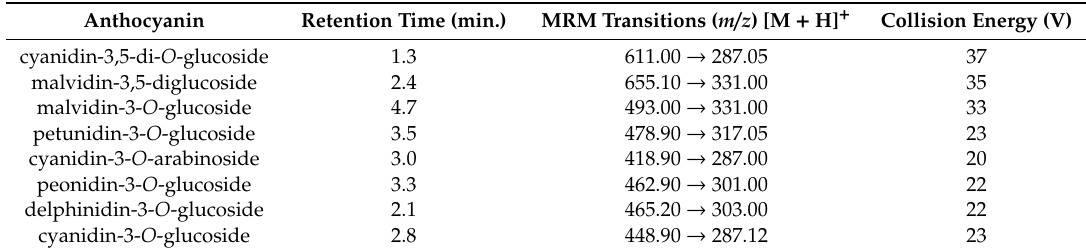
Table 1. Optimized multiple reaction monitoring (MRM) conditions for LC-MS / MS analyses of anthocyanins.